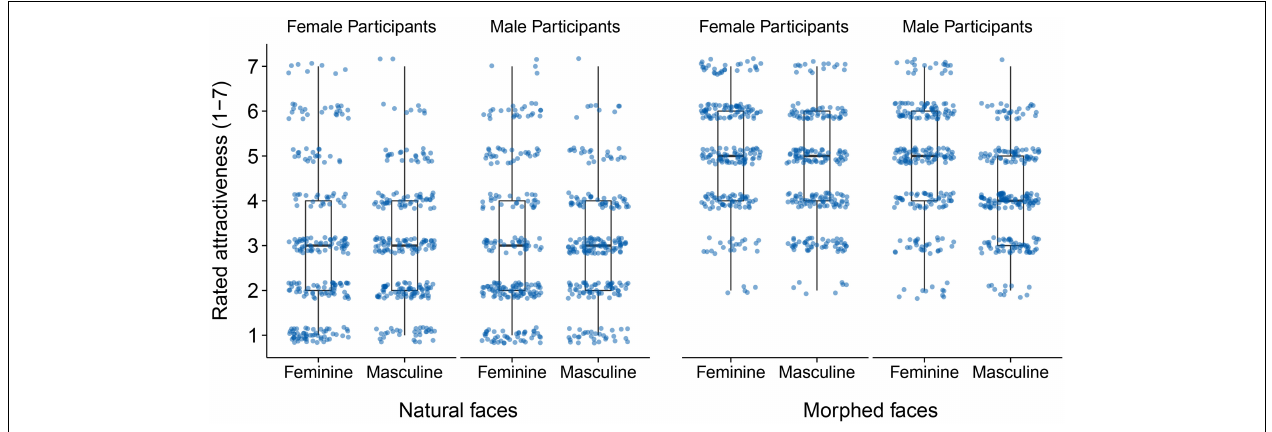
FIGURE 3 | Distribution of all subjective attractiveness judgments collected in Experiment 1. Dots represent raw data points ( n = 960 in each of the two stimulus sets) and are displayed jittered on the discrete rating scale for better visualization.